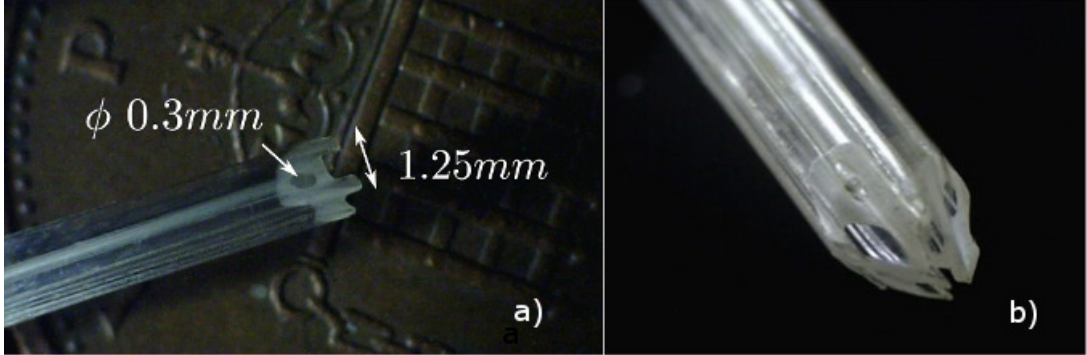
Figure 3. ( a ) Medical grade PBN needle cross-section; and ( b ) four-part needle PBN